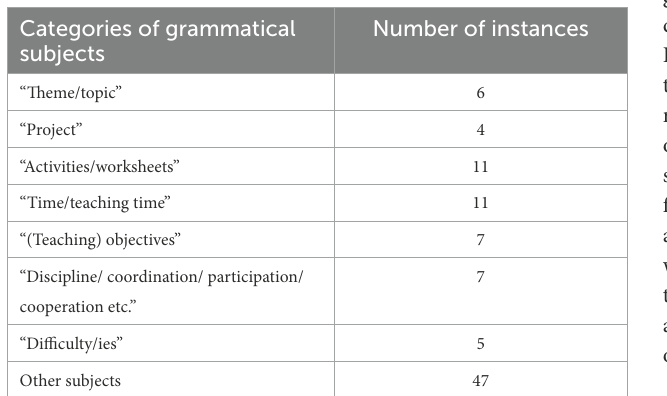
TABLE 3 “Inanimate” subjects.